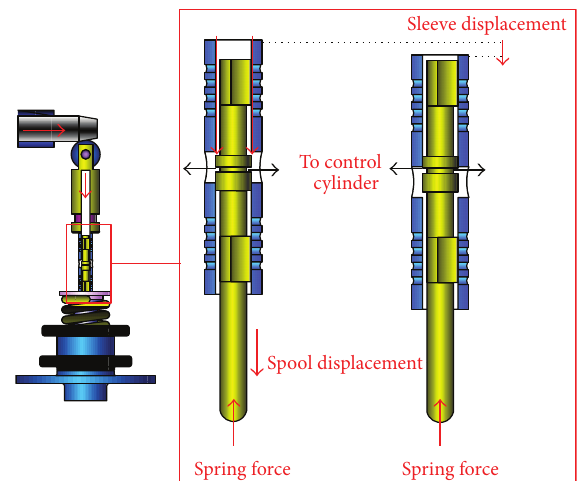
Figure 11: Schematic of constant power regulator for the case of constant